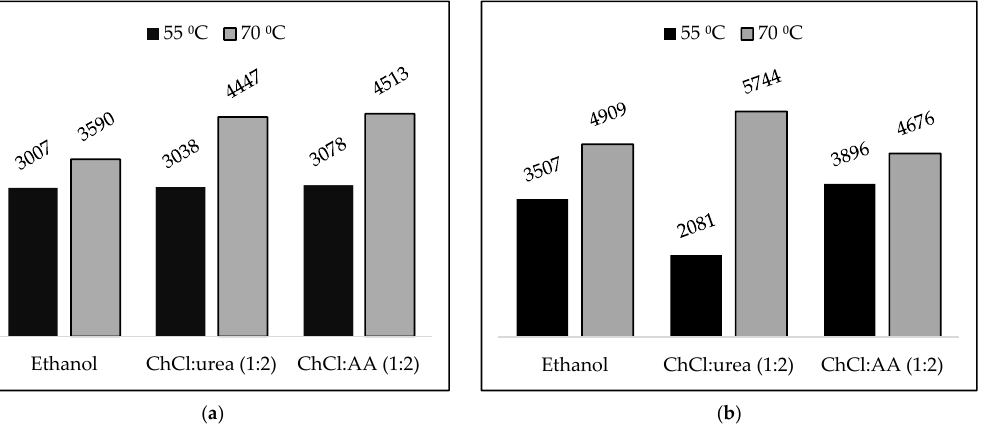
Figure 1. Effect of temperature on ( a ) antioxidant activity (mg Trolox/L) and ( b ) total phenolic content (mgGA/L) in extracts obtained by conventional extraction at the biomass to solvent mass ratio of 1:20 w / w